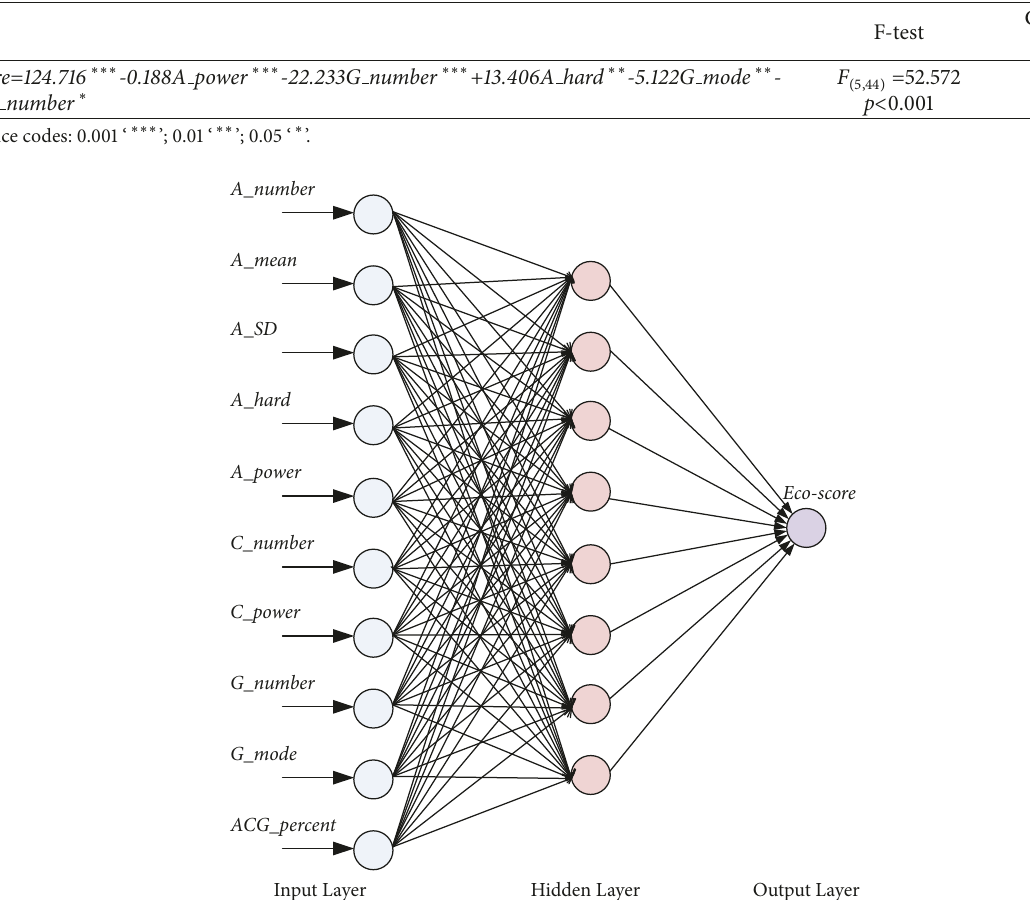
Table 4: Linear regression model to predict ecoscore of individual driver performance.